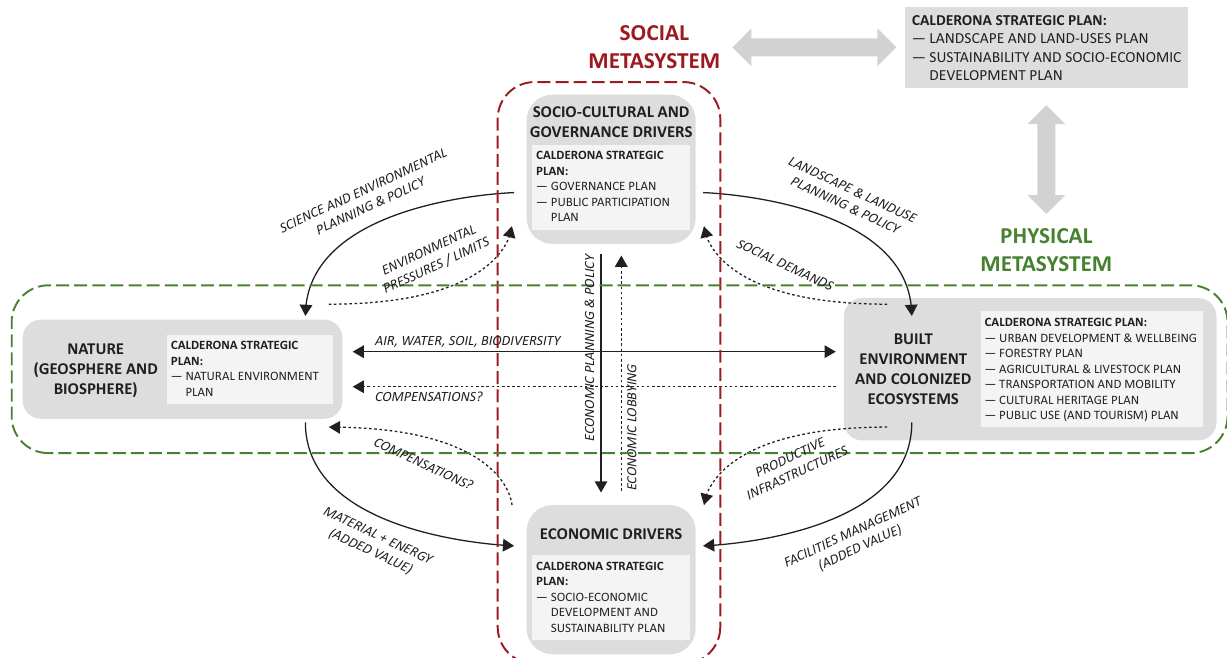
Figure 3. Integration of the social and physical metasystems in the SCSP and links with the proposed sectoral plans, land- scape and land use plan, and overarching metabolic studies. Source: based on the model for resources correlations within a regional urban system in Baccini and Brunner